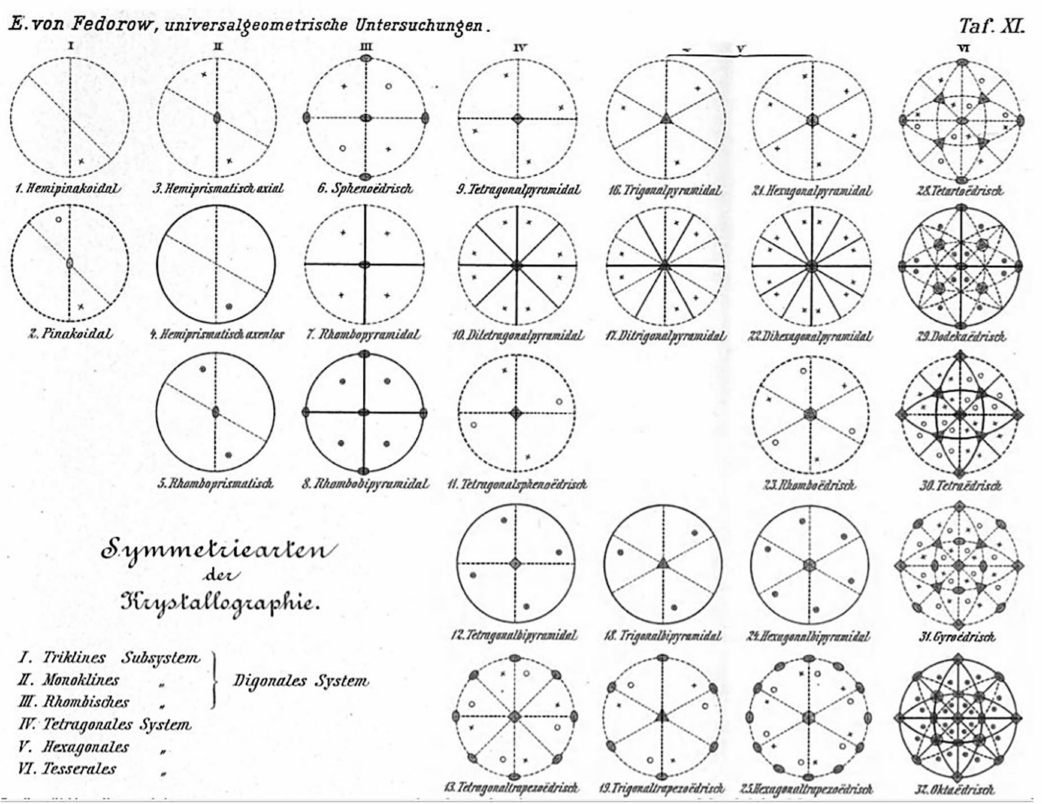
Figure 6. Part of the figure summarizing symmetry types “Symmetriearten der Krystallographie” which was published by Fedorov in Z. Kryst. 1893 [32] (Table XI). Note that standardized graphics of stereographic projections of symmetry axes and planes, poles of general position as well as designations of each class below the graphics are given (Fedorov-Groth